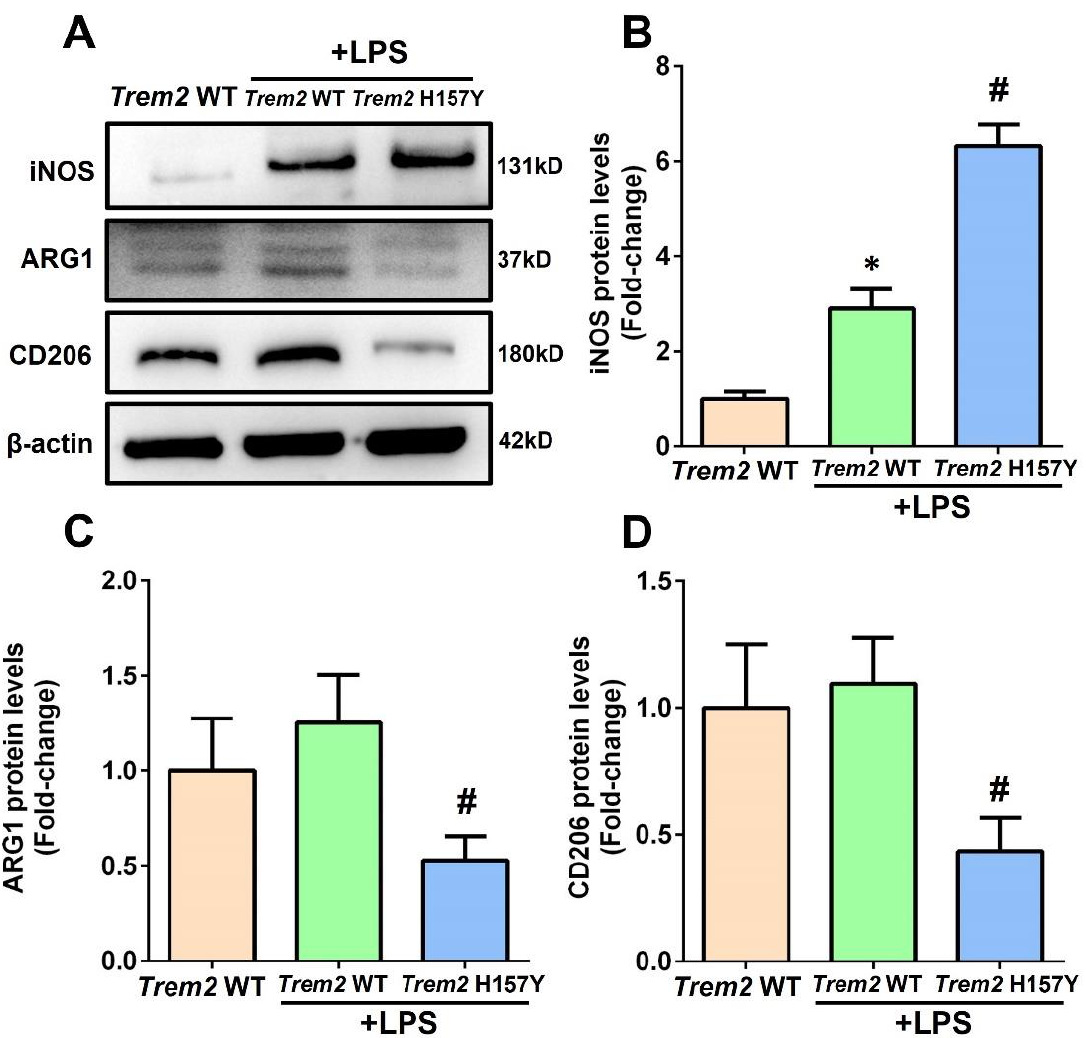
Figure 2. The Trem2 H157Y variant promotes M1-type polarization of microglia. ( A ) Levels of iNOS, ARG1, and CD206 in WT Trem2 BV2 microglia and BV2 microglia with the Trem2 H157Y variant after LPS stimulation were detected by Western blot analysis. ( B – D ) Quantitative analysis of iNOS, ARG1, and CD206 protein levels. Data were normalized to β -actin. Data were analyzed by one-way ANOVA followed by Tukey’s post hoc test. Columns represent means ± SDs (n = 3, performed in triplicates). * p < 0.05 versus WT Trem2 BV2 microglia without LPS stimulation; # p < 0.05 versus LPS-stimulated WT Trem2 BV2 microglia. 3.3. The Trem2 H157Y Variant Facilitates Microglial Release of Inflammatory